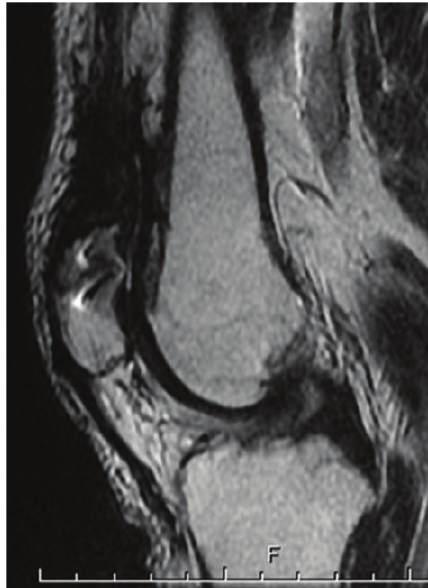
Figure 9: Sagittal postoperative MRI proton density-weighted image. Continuity of the tendon was maintained.